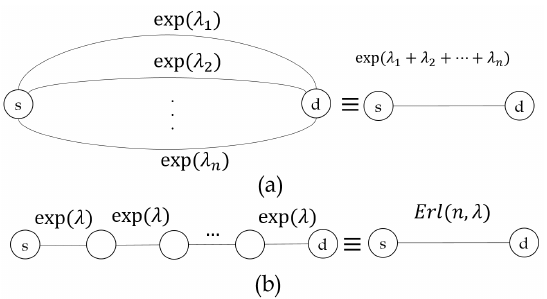
Figure 3. Links deliver probabilistically under the exponential distribution with expected delivery times of 1/ λ 1 , . . . ,1/ λ n after the arrival of the message to the source node. ( a ) is parallel links reduction. ( b ) is series links